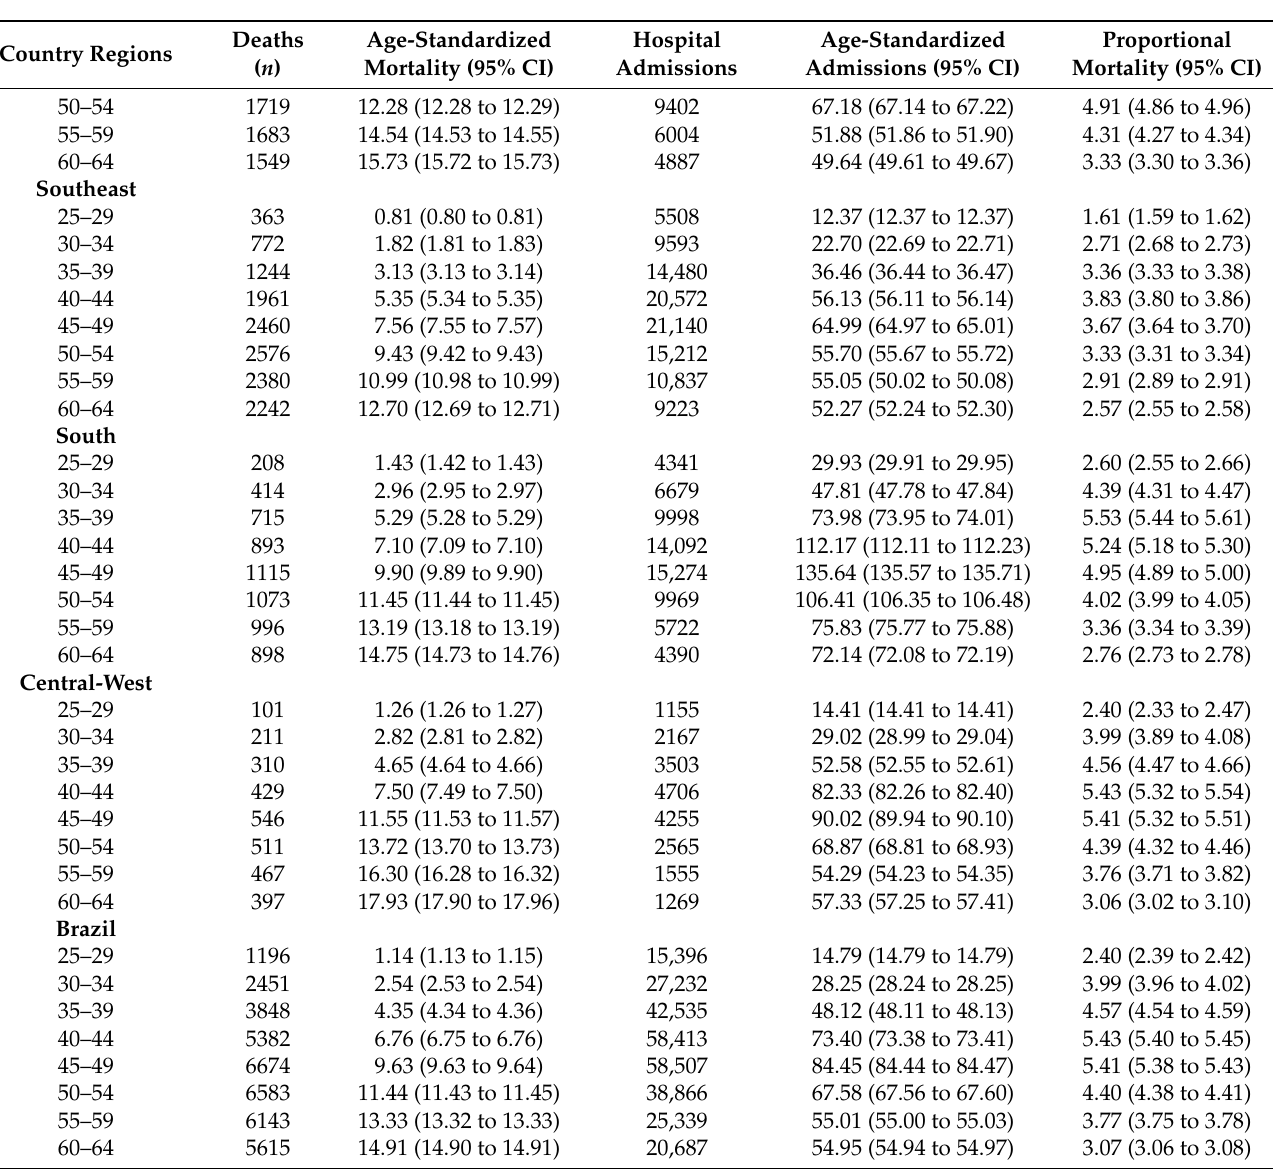
* Crude rate. International classification of diseases. 10th revision. Codes C53. Source: Mortality Information System (SIM) and Hospital Information System (SIH/SUS). Data made available by the Department of Informatics of The National Health System (DATASUS— www.datasus.gov.br (accessed on 12 April 2019). Ministry of Health.